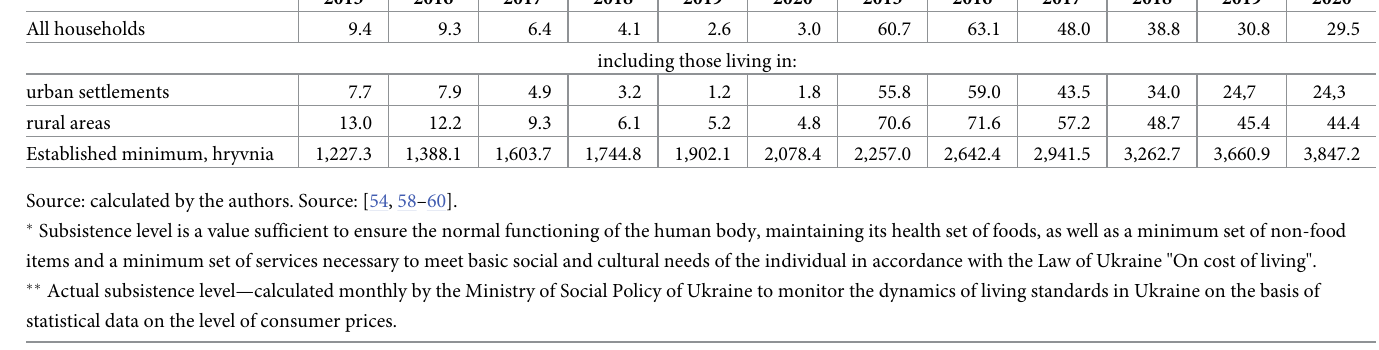
Table 2. Distribution of households with per capita equivalent money income for a month below subsistence line, %. Share of households with per capita equivalent cash income per month is lower the statutory established minimum subsistence level